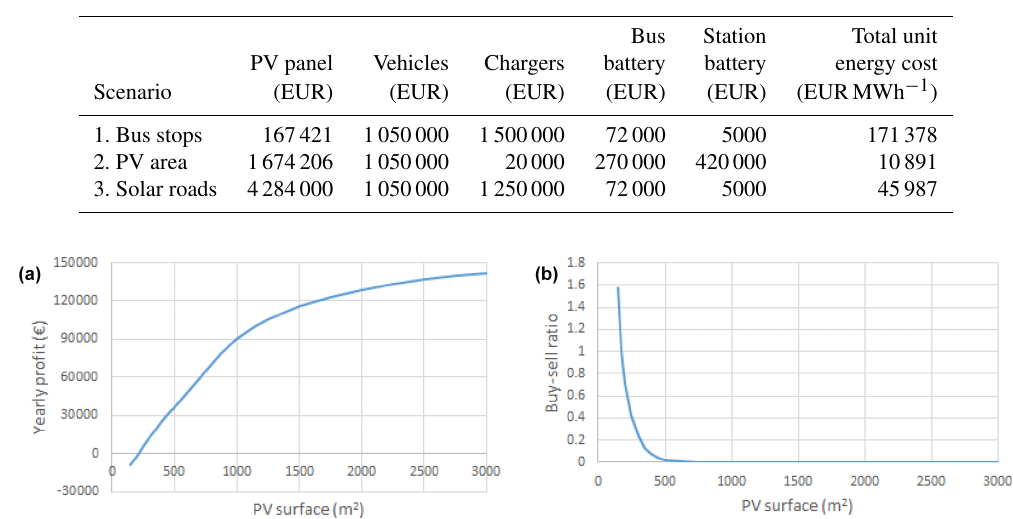
Table 2. Capital cost analysis.